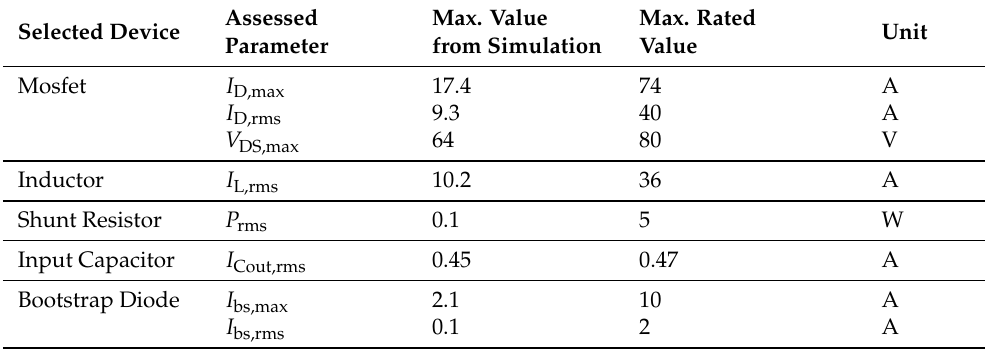
Table 5. Main components adopted for the power stage. Considered electrical limit parameters extracted from the datasheets and related maximum values obtained in